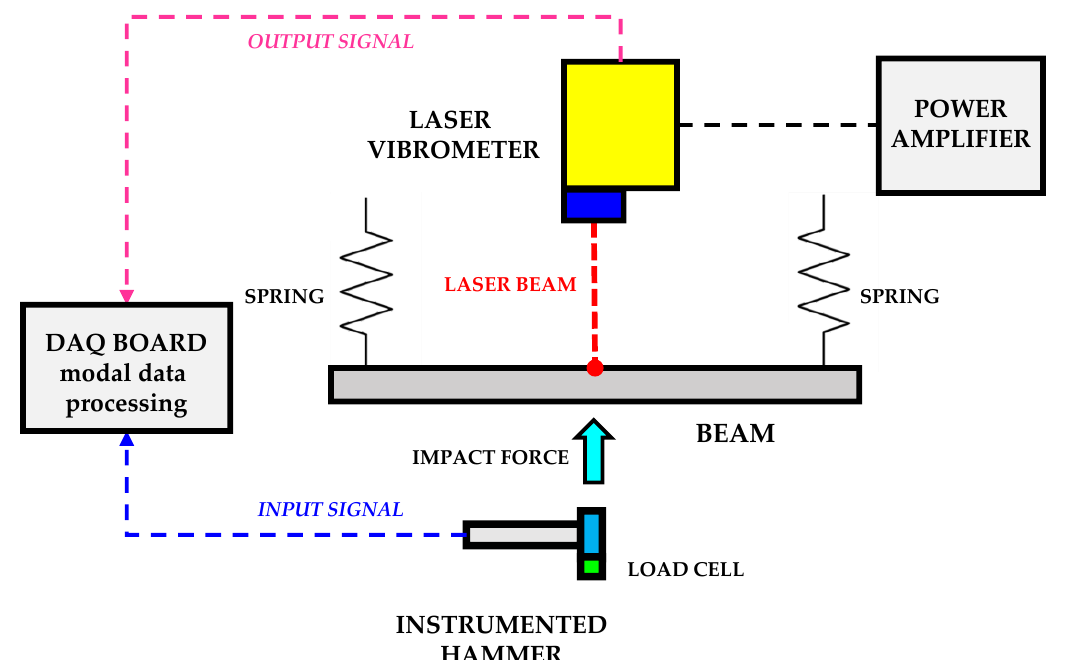
Figure 8. Experimental setup schematic to measure the damping material in free-free conditions.